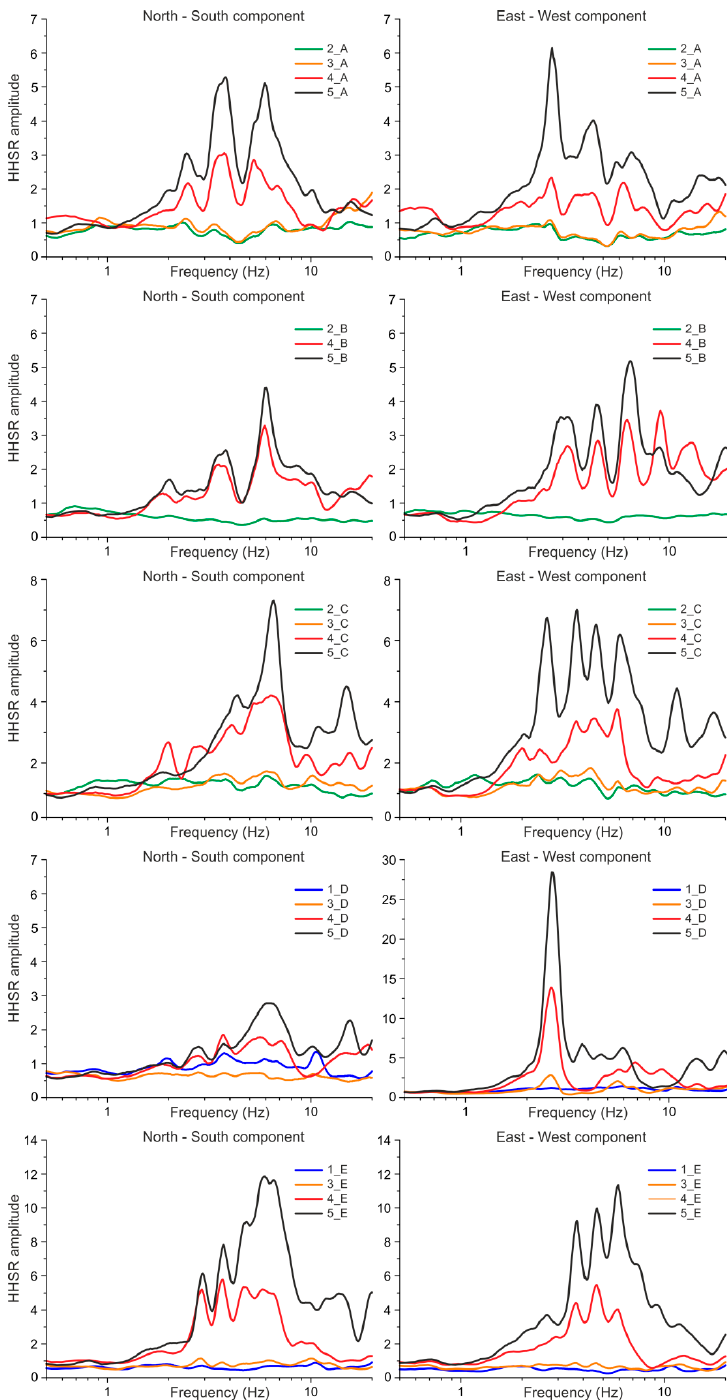
Figure 4. Horizontal-to-horizontal spectral ratio (HHSR) plots obtained from noise recordings performed at floors one (basement) to five (roof) for the sites A, B, C, D, and E.